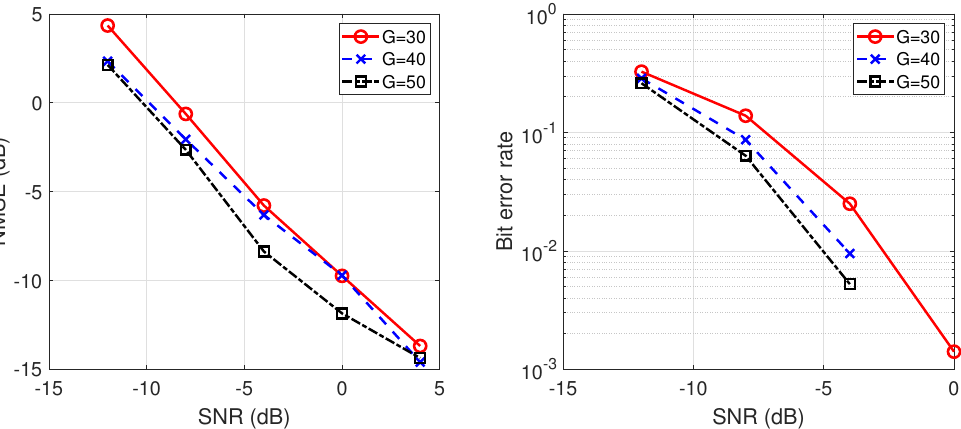
Figure 5. NMSE of estimated spreading waveform and BER of information sequence ( I = 2, L = 63, R = 3, M = 100).